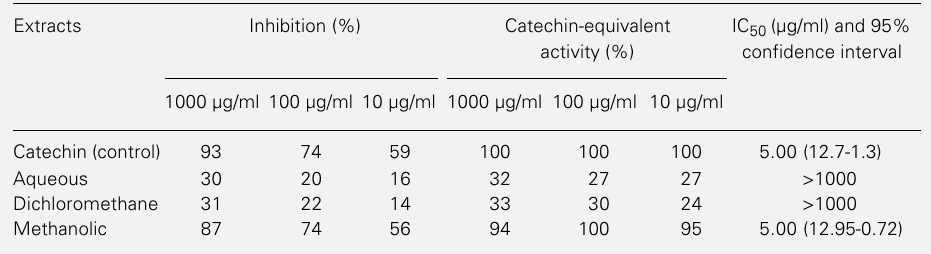
Table 3 - Effect of P. peltata extracts on free radical-mediated DNA-sugar damage and catechin-equivalent activity. Percent of inhibition of iron (II)-mediated DNA-sugar damage was calculated by (1 - Dtm/Dcm) x 100. Dtm: fluorescence in test samples; Dcm: fluorescence in controls. Catechin was used as a standard. Catechin- equivalent activity was calculated as described in the legend to Table